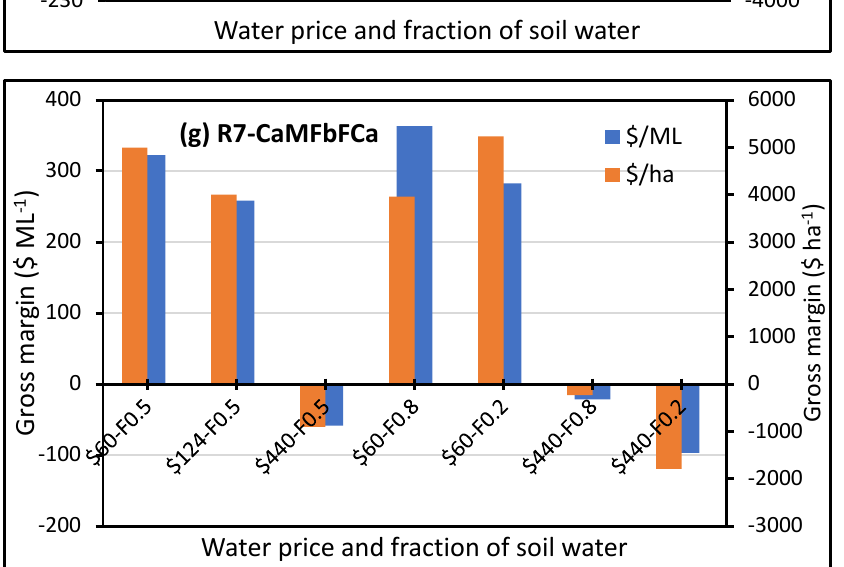
Figure 8. Total gross margin per unit of water and per unit cultivated land for different water prices ($) and available soil water fractions (F).